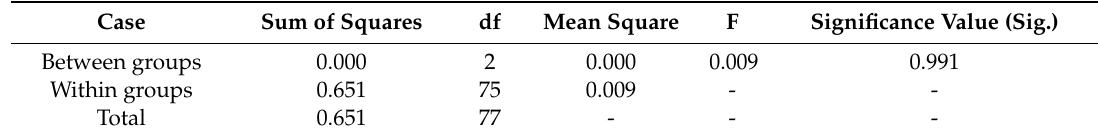
Table 4. ANOVA test performance for validation